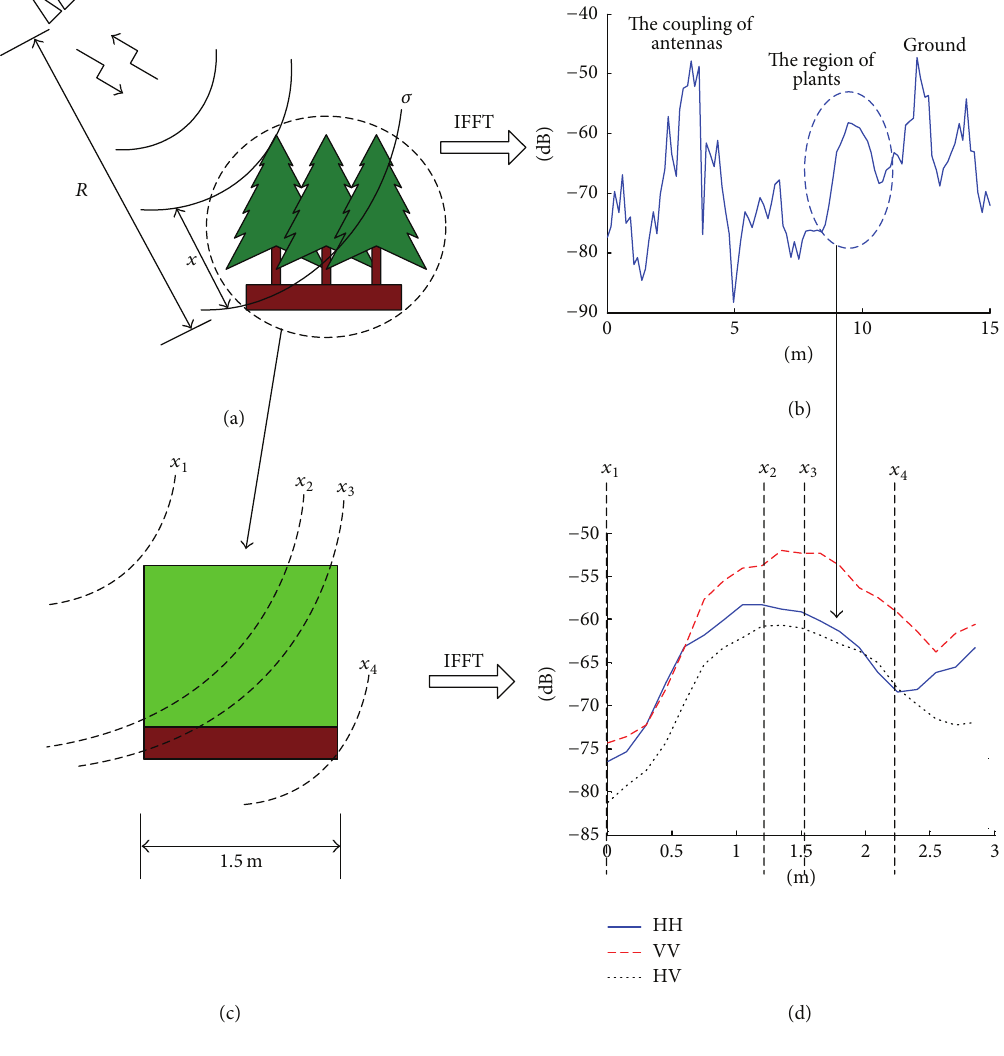
Figure 1: Propagation of waves in